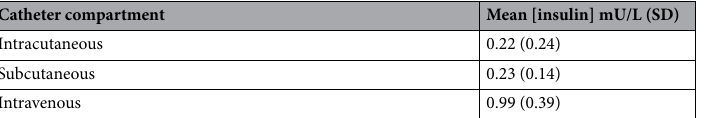
Table 2. Concentration of insulin adsorbed to the microdialysis membranes from the different in vivo compartments (intracutaneous, subcutaneous and intravenous), analyzed with ELISA. Data presented in mean (SD).